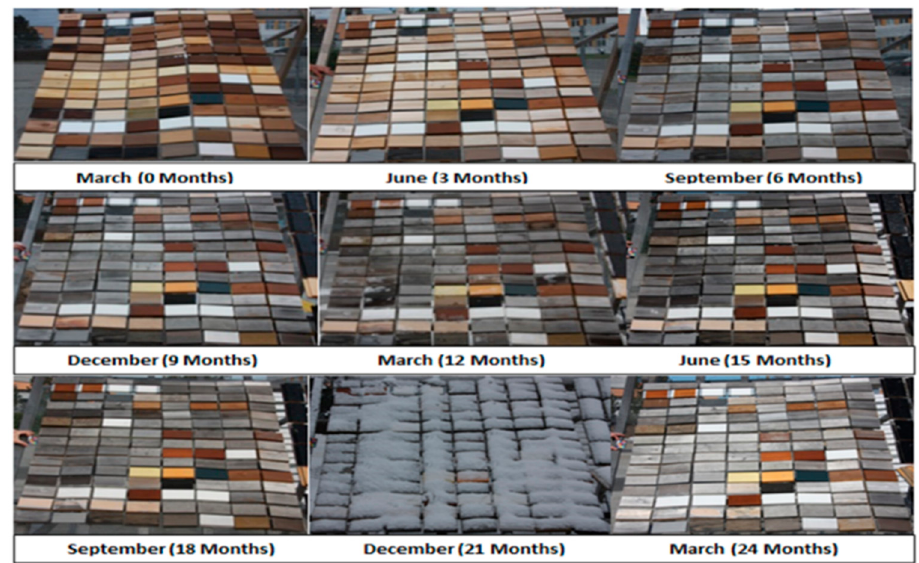
Figure 5. Experimental samples during natural weathering in Tallinn (2 years).